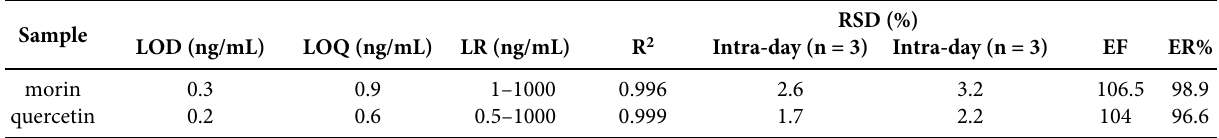
Table 2. Analytical performance of AALLME-SFO for the determination of morin and quercetin Sample